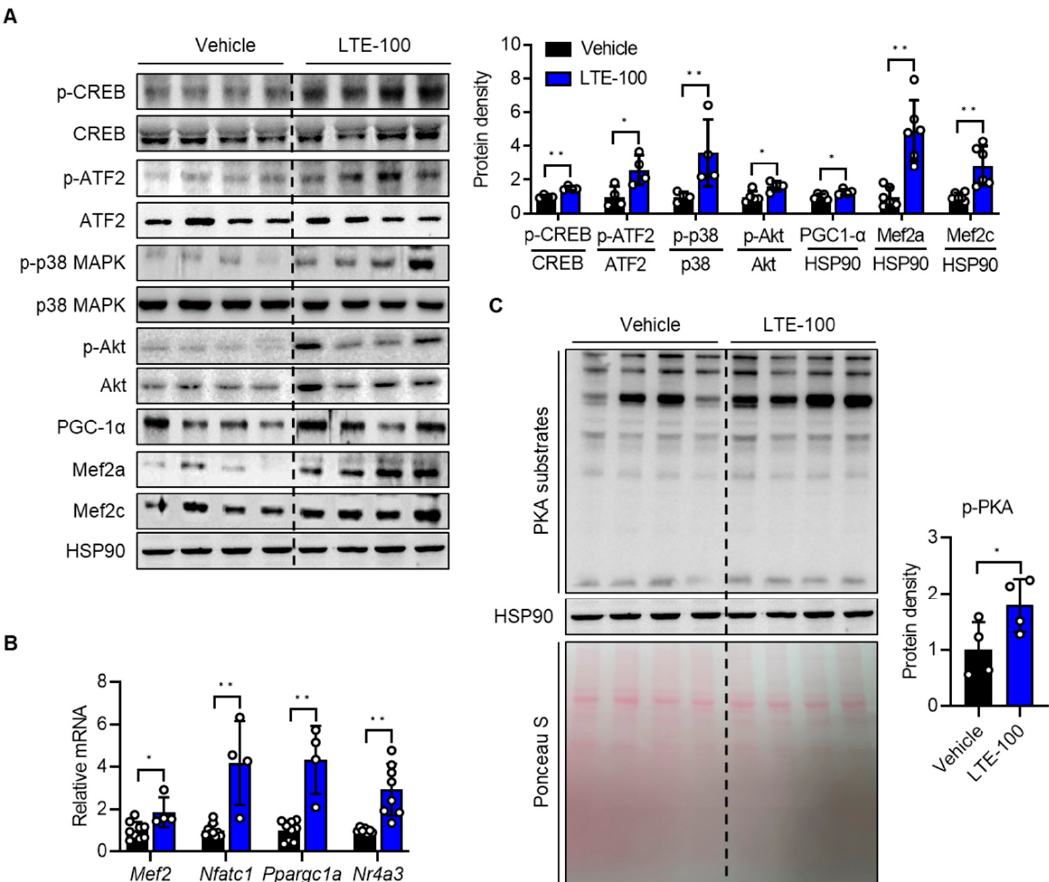
Figure 5. Effects of LTE supplementation on the signaling pathways leading to mitochondrial bio- genesis and function . ( A ) Western blotting analysis of the genes involved in mitochondrial biogen- esis in GAS muscles. Quantification results are shown ( n = 4–6). ( B ) qPCR analysis of genes related to mitochondrial biogenesis ( n = 4–9). Expression of each gene was normalized with housekeeping gene Gapdh . ( C ) Western blotting of PKA substrates. The red Ponceau S-stained gel is shown as loading control. Values are mean ± S.E.M. * p < 0.05 and ** p < 0.01. LTE-100, LTE 100 mg/kg p.o.